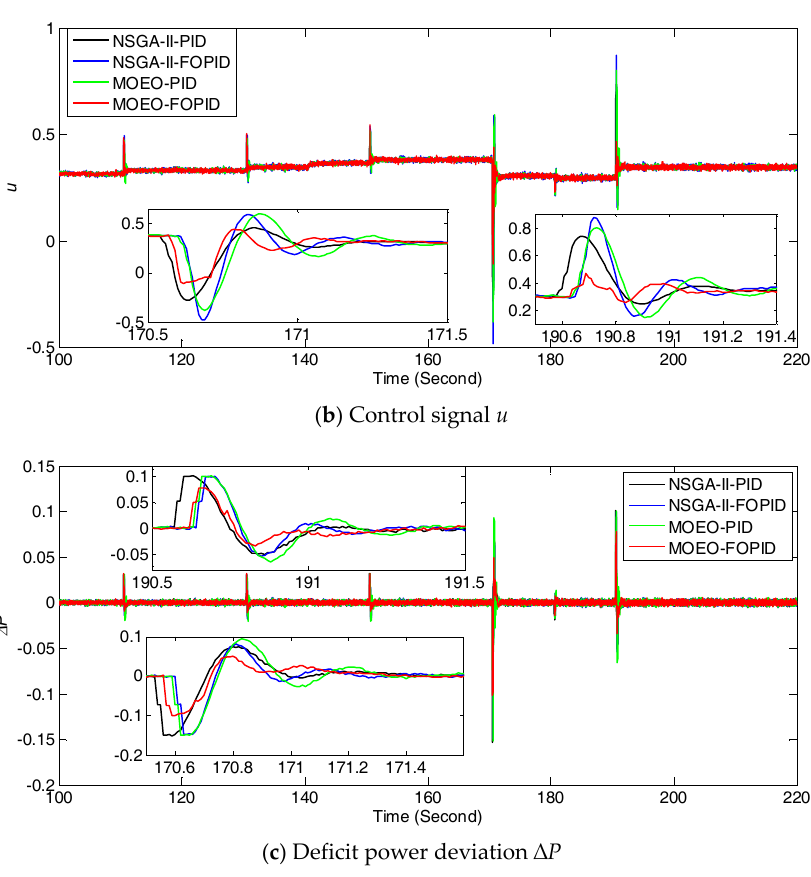
Figure 6. Comparison of frequency deviation ∆ f ( a ), control signal u ( b ) and deficit power deviation ∆ P ( c ) of the test microgrid with the best FOPID/PID controllers obtained by the NSGA-II and MOEO algorithms.